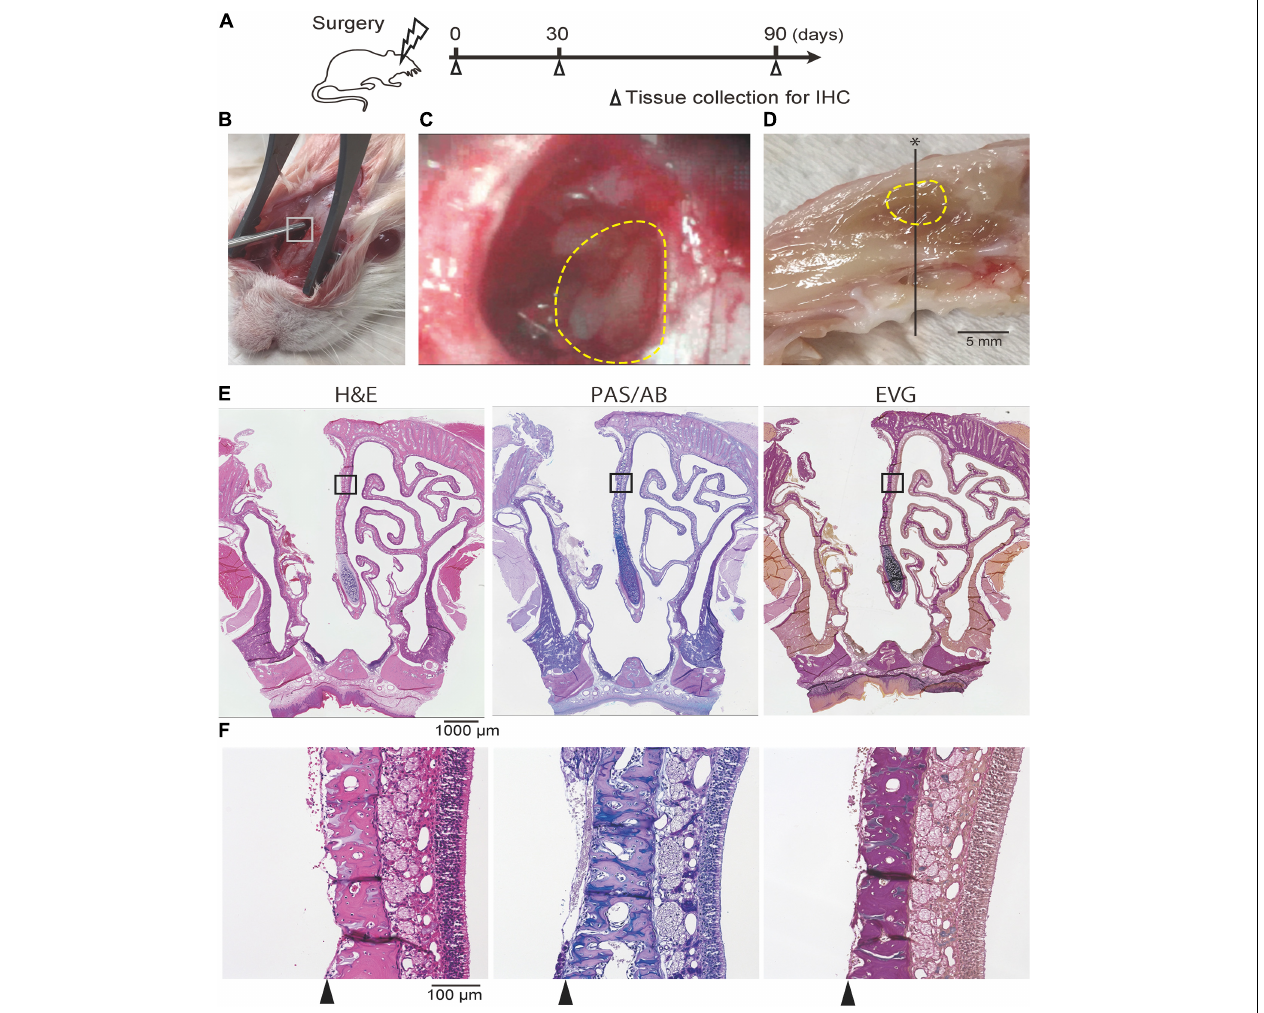
FIGURE 1 | (A) Experimental timeline. (B, C) Photographic images of the surgical procedure. The box in (B) indicates the area where the hole was drilled; this is shown at a higher magnification in (C) . The dotted line indicates the area where the nasal mucosa was resected. (D) Mid-sagittal section of the rat nose. The dotted line indicates the area where the nasal mucosa was resected. The black line represents the line along which sections were cut. (E,F) Representative images of sections of the rat nose taken after partial nasal mucosal resection on day 0; hematoxylin and eosin (H&E) staining, Periodic Acid-Schiff and Alcian Blue (PAS/AB) staining, and Elastica van Gieson (EVG) staining are shown. The insets in (E) are shown at higher magnification in ( F ; E , 40 × magnification; F , 200 × magnification). The nasal mucosa, including the olfactory epithelium and subepithelial tissue, was completely resected along the perichondrium of the nasal septum (arrowheads).